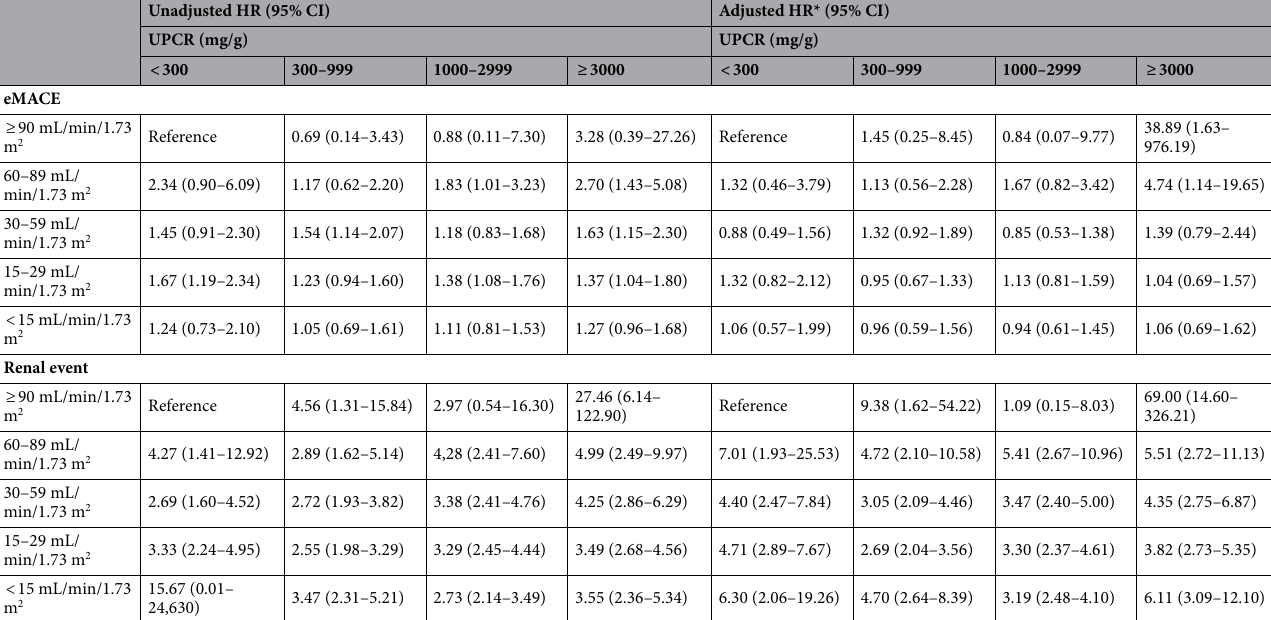
Table 2. Hazard ratios (with 95% confidence interval) for extended major adverse cardiovascular events (eMACEs) and renal events according to category of estimated glomerular filtration rate (eGFR) and urine